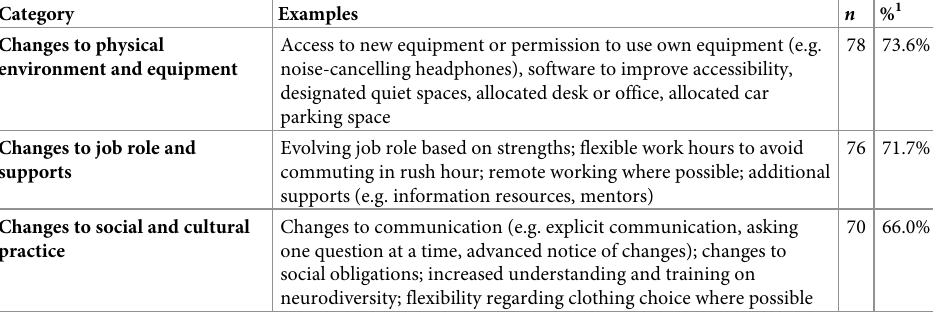
Table 3. Workplace adjustments participants reported requesting ( n =